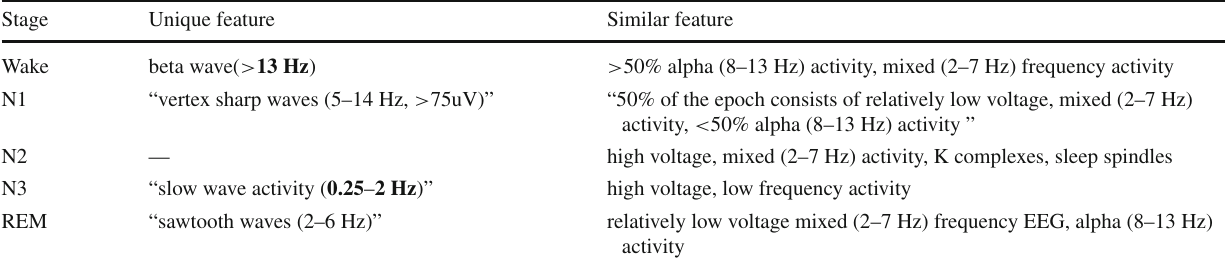
Table 1 Characteristic of each stage, adapted from AASM Stage Unique feature Similar